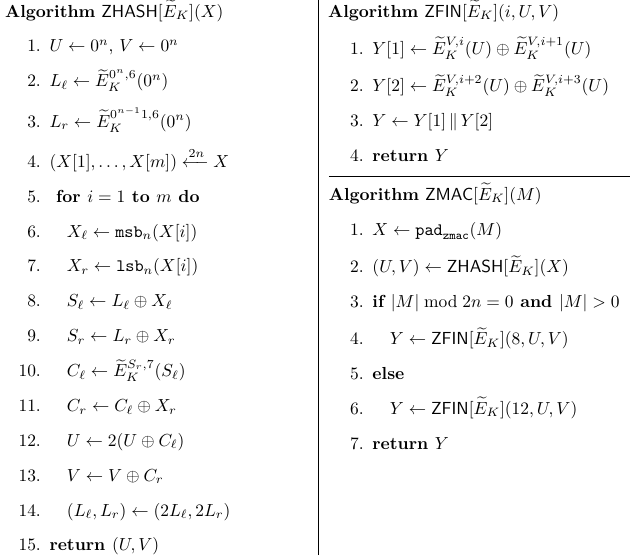
is a non-injective padding defined over 2 n -bit blocks: zmac